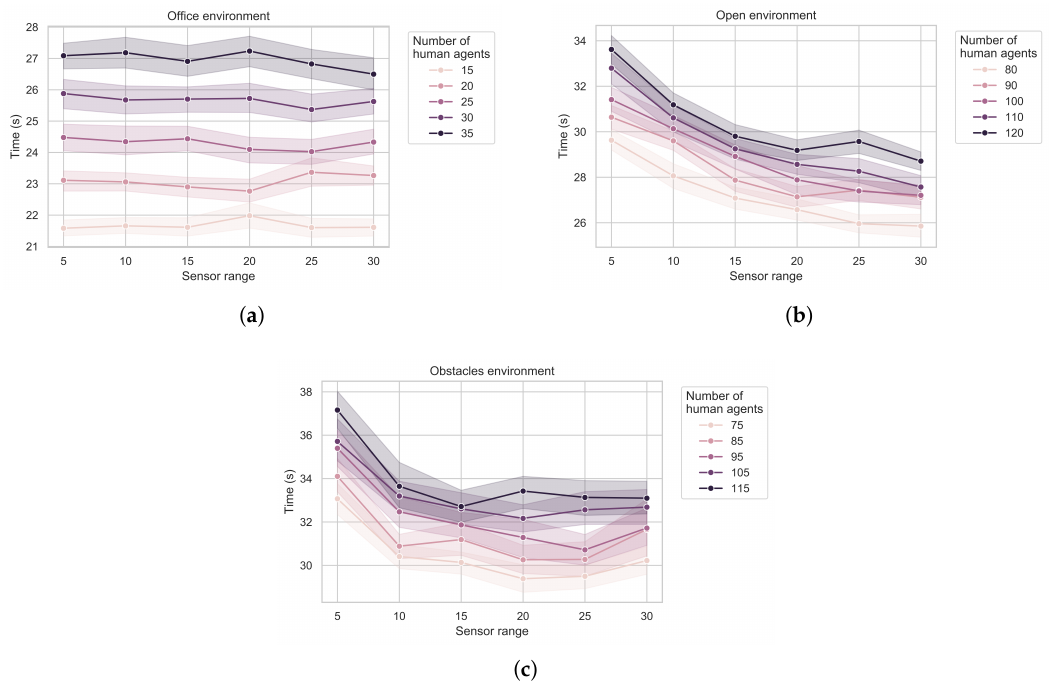
Figure 4. Mean time and 95% confidence intervals (shaded area) taken by the robot to complete navigation in the ( a ) office, ( b ) open, and ( c ) obstacles environment as a function of sensor range and number of